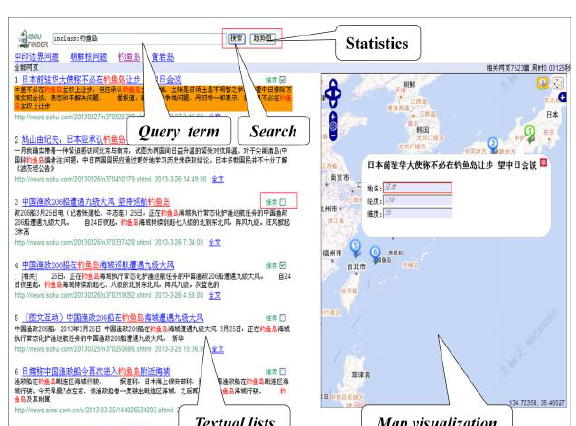
Figure 4. GUI of the focused crawling module